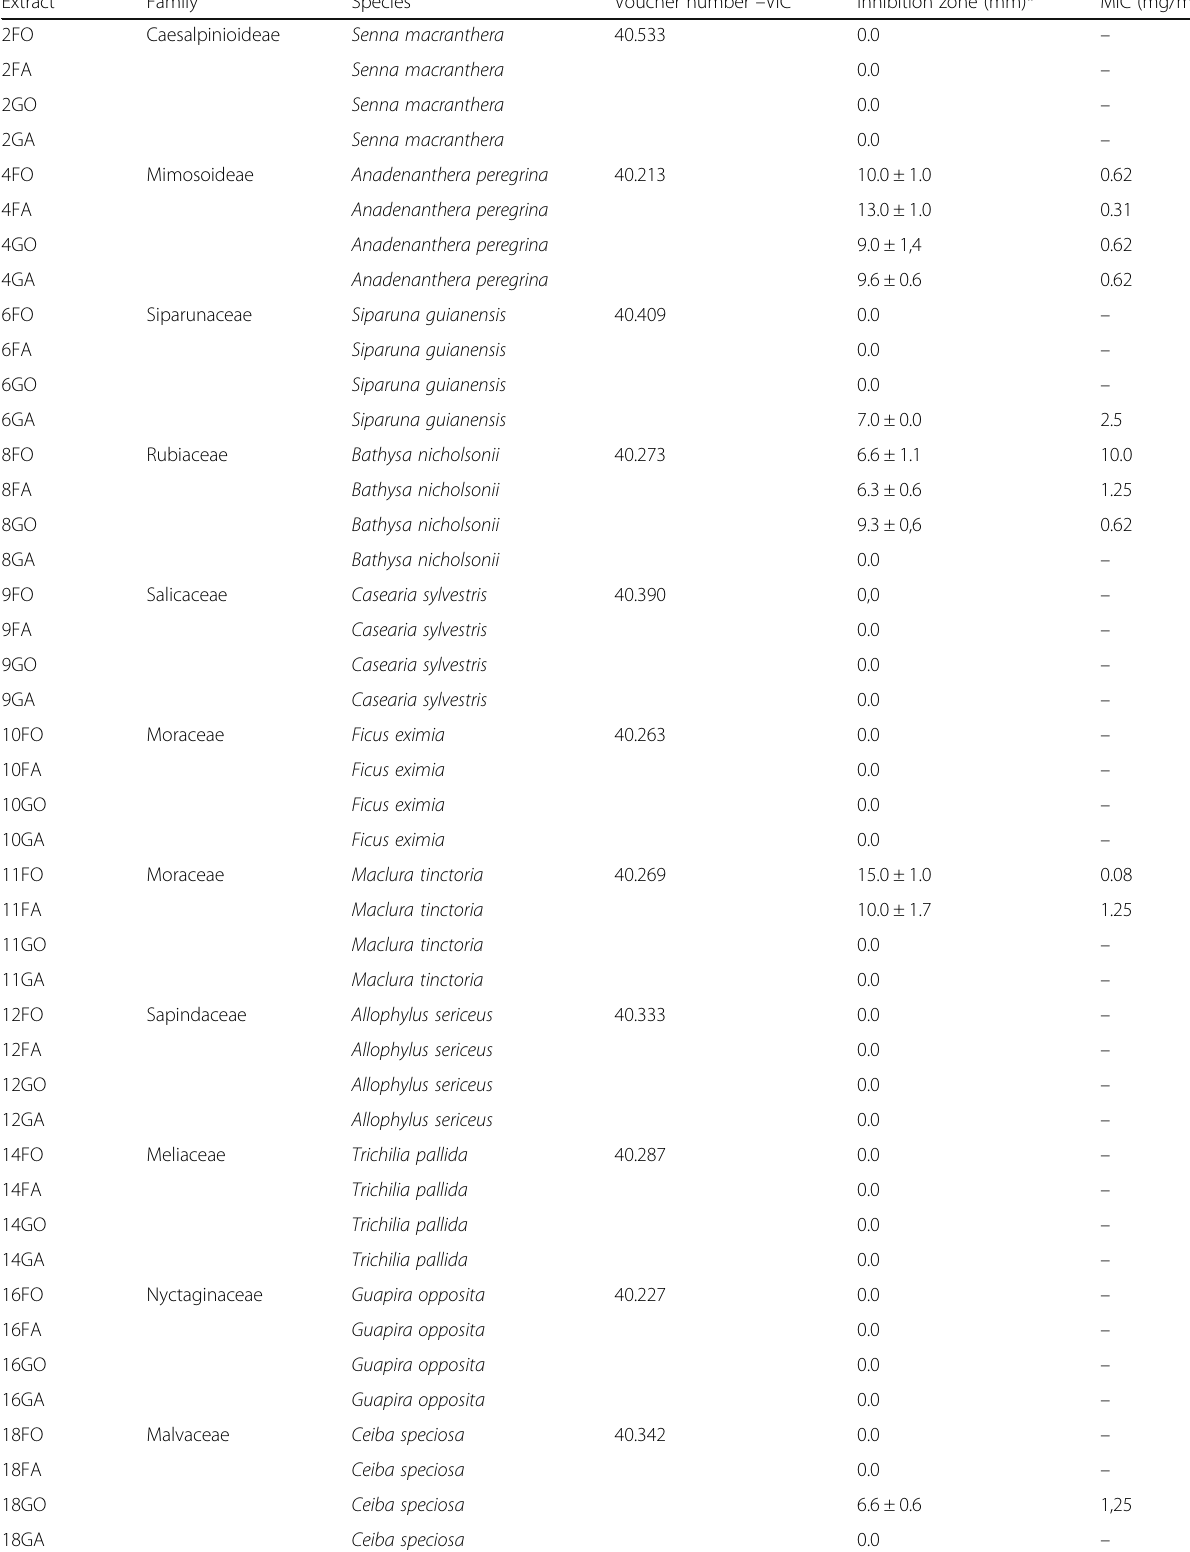
Table 1 Antimicrobial activity of plant extracts against Staphylococcus aureus ATCC 29213